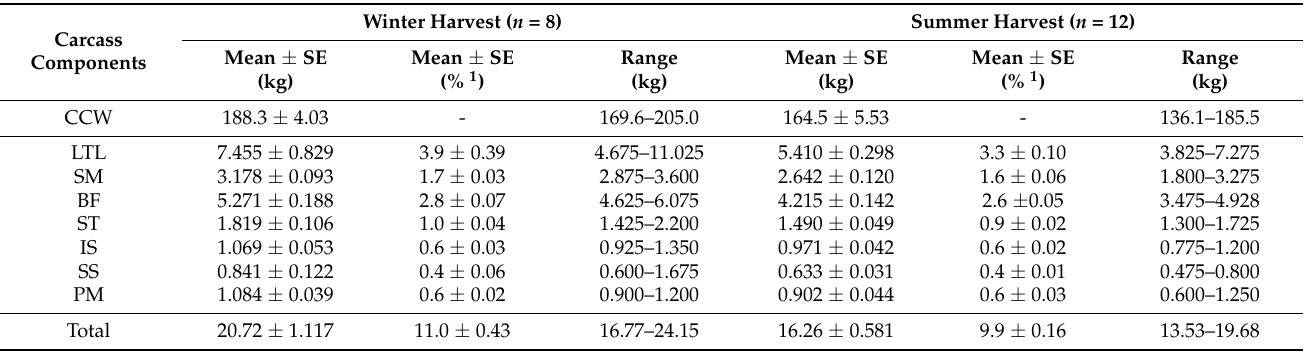
Table 5. Muscle yields from eight Plains zebra stallions harvested in the winter and 12 Plains zebra stallions harvested in the summer season. The results are reported as Means ( ± standard error), minimum and maximum of the muscle weight (kg) and contribution (%) to the cold carcass weight. Carcass